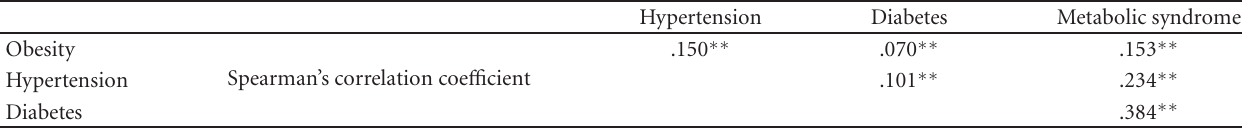
Table 5: Relationship between the prevalence of MS and other cardiovascular risks.